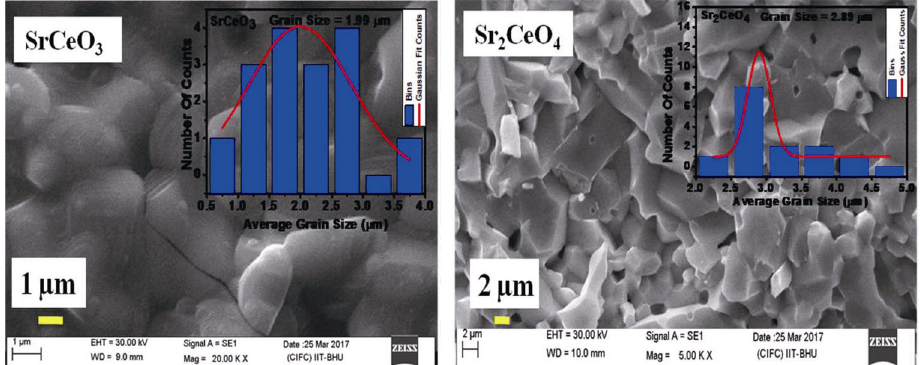
Fig. 4 SEM images of fractured surfaces of sintered pellets.